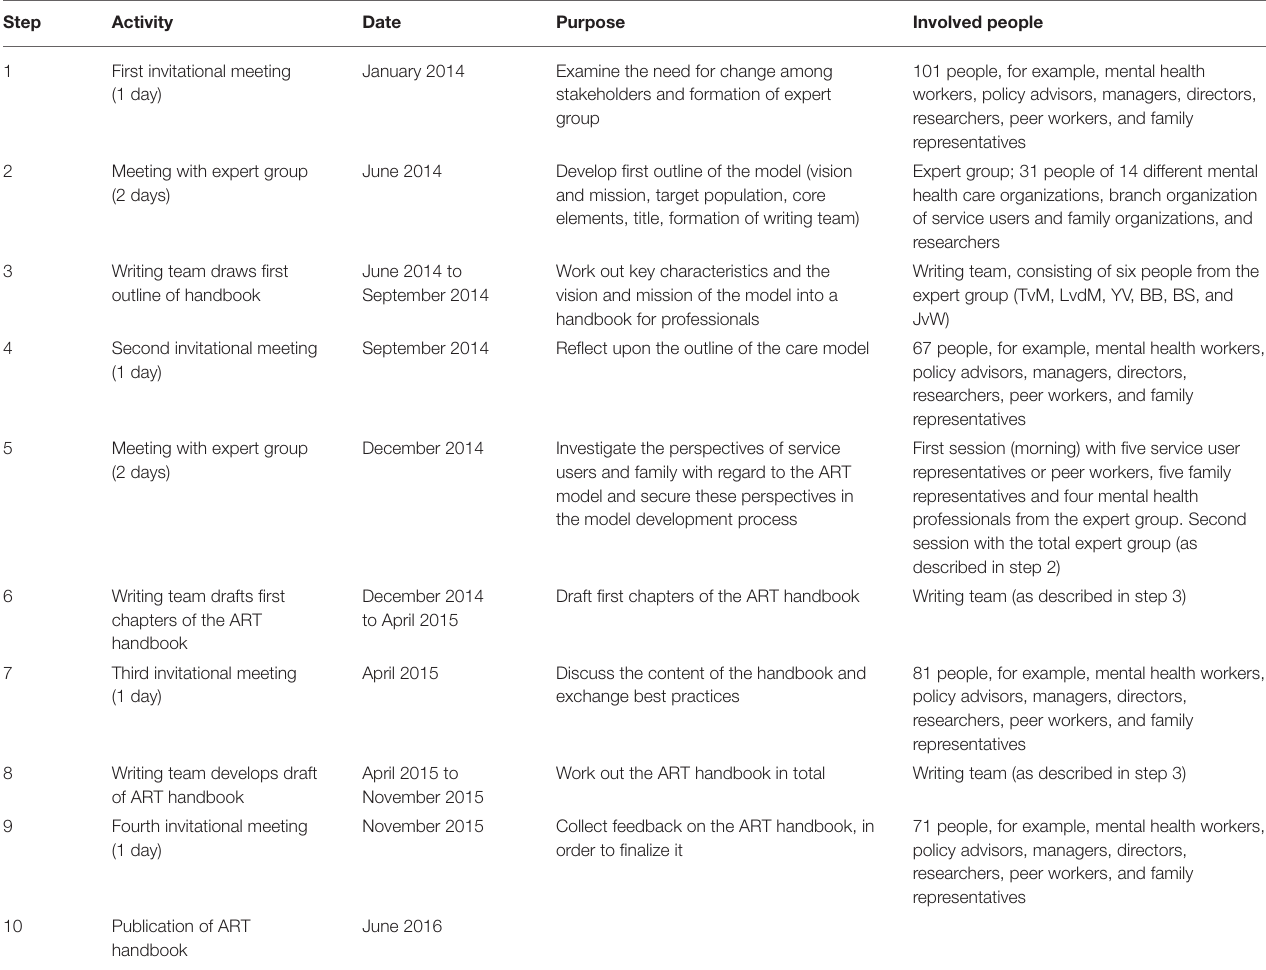
TABLE 1 | The development process of the ART